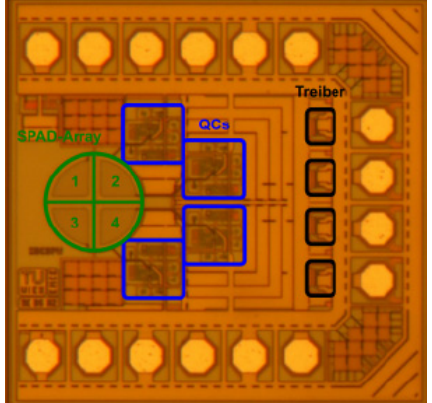
Figure 4. Chip photo of 4-SPAD receiver.